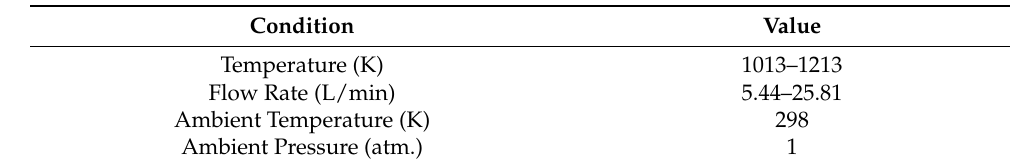
Table 2. Experiment conditions [27].